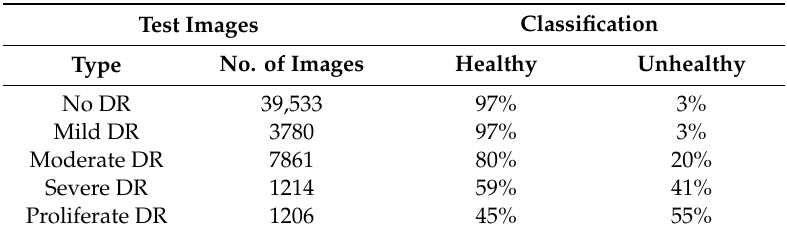
Table 7. Results from the Keras